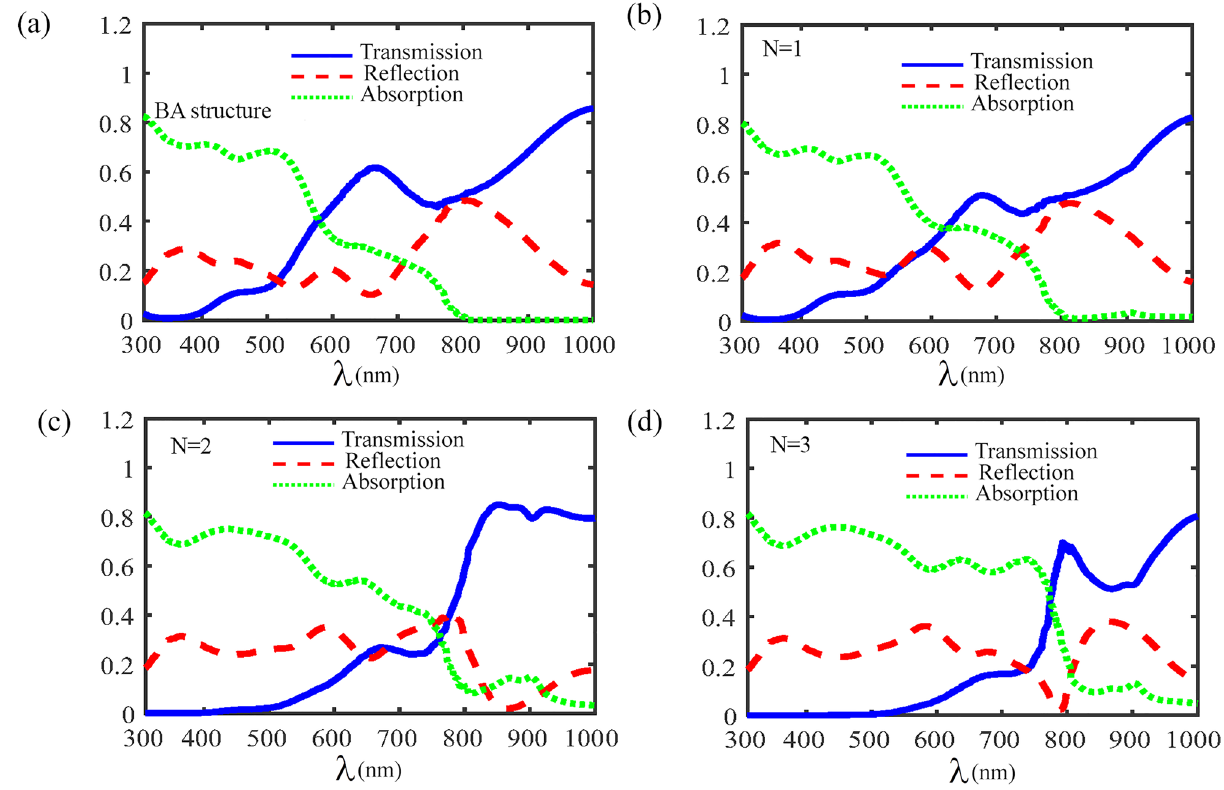
Figure 2. The absorbance, transmittance and reflectance coefficients versus light wavelength for the normal o incident angle θ i = 0 , ( a ) for BA structure, ( b ) N = 1, ( c ) N = 2 and ( d ) N = weak absorbance around 900 nm, due to the presence of the monolayer MoS 2 . Considering that the CH 3 NH 3 PbI 3 layer and monolayer MoS 2 alone have very weak absorption in longer wavelengths 52,59,60 . However, due to the optical localization in CH 3 NH 3 PbI 3 -based photonic crystal in the presence of the monolayer MoS 2, this structure enhances the light absorption at longer wavelengths. This phenomenon will be more evident with the increase in the number of periods. Also, as the number of periods increases, the absorbance coefficient increases, especially at longer wavelengths. In addition, for BA structure or N = 1, the transmittance coefficient of the photonic crystal is zero over a small wavelengths range ( 300 nm < (cid:31) < 400 nm ) , and this range increases with increasing the number of periods. To further investigate the dependence of the absorbance coefficient on the incident light angle in the CH 3 NH 3 PbI 3 -based photonic crystal, the absorbance coefficient versus the incident light angle and wavelength of electromagnetic waves, for various number of periods is shown in Fig. 3. According to the figure, it is clear that for BA structure, for incident waves with longer wavelengths ( (cid:31) > 800 nm ) , the photonic crystal has no absorbance in this region. This phenomenon is because the CH 3 NH 3 PbI 3 alone has very weak absorption in longer wavelengths 52,59 . Therefore, two different areas can be defined according to the wavelength of incident light: (cid:31) < 800 nm , and (cid:31) > 800 nm , in the first area, unlike the second area, the absorbance is non-zero. Thus, the absorbance versus the angle of the incident light and incident light wavelength has a gap. Moreover, for N = 1, a weak absorbance is observed around the incident wavelength of 900 nm, and with increasing number of periods, the absorbance occurs in most parts of the second region, due to the optical localization. According to Figs. 2 and 3, the absorbance, reflectance and transmittance coefficients for different wavelengths of incident light in a CH 3 NH 3 PbI 3 perovskite-based photonic crystal in the presence of monolayer MoS 2 can be effectively controlled by the angle of the incident light and number of periods. In other words, absorbance coefficient depends on the number of periods and has an oscillatory behavior with respect to the angle of the incident light. This is because of the fact that the absorbance coefficient is an oscillating function of α j , which is determined by θ j . The dependence of the absorbance, transmittance and reflectance coefficients on the thickness 0 o , is shown in Fig. 4. From Fig. 4, it is apparent of the CH 3 NH 3 PbI 3 layer for the normal incident angle θ i = 500 nm ), the transmittance coefficient decreases that, for incident light in the visible region (for example, (cid:31) = exponentially with increasing thickness of the CH 3 NH 3 PbI 3 layer, due to the evanescent mode. Also, with increas- ing the number of periods, this decrease occurs faster, due to the strong light localization. Further, for visible incident light and for BA structure or N = 1, the absorbance and reflectance coefficients have an oscillatory behavior with respect to the thickness of the CH 3 NH 3 PbI 3 layer. The reason for this behavior is the interface of CH